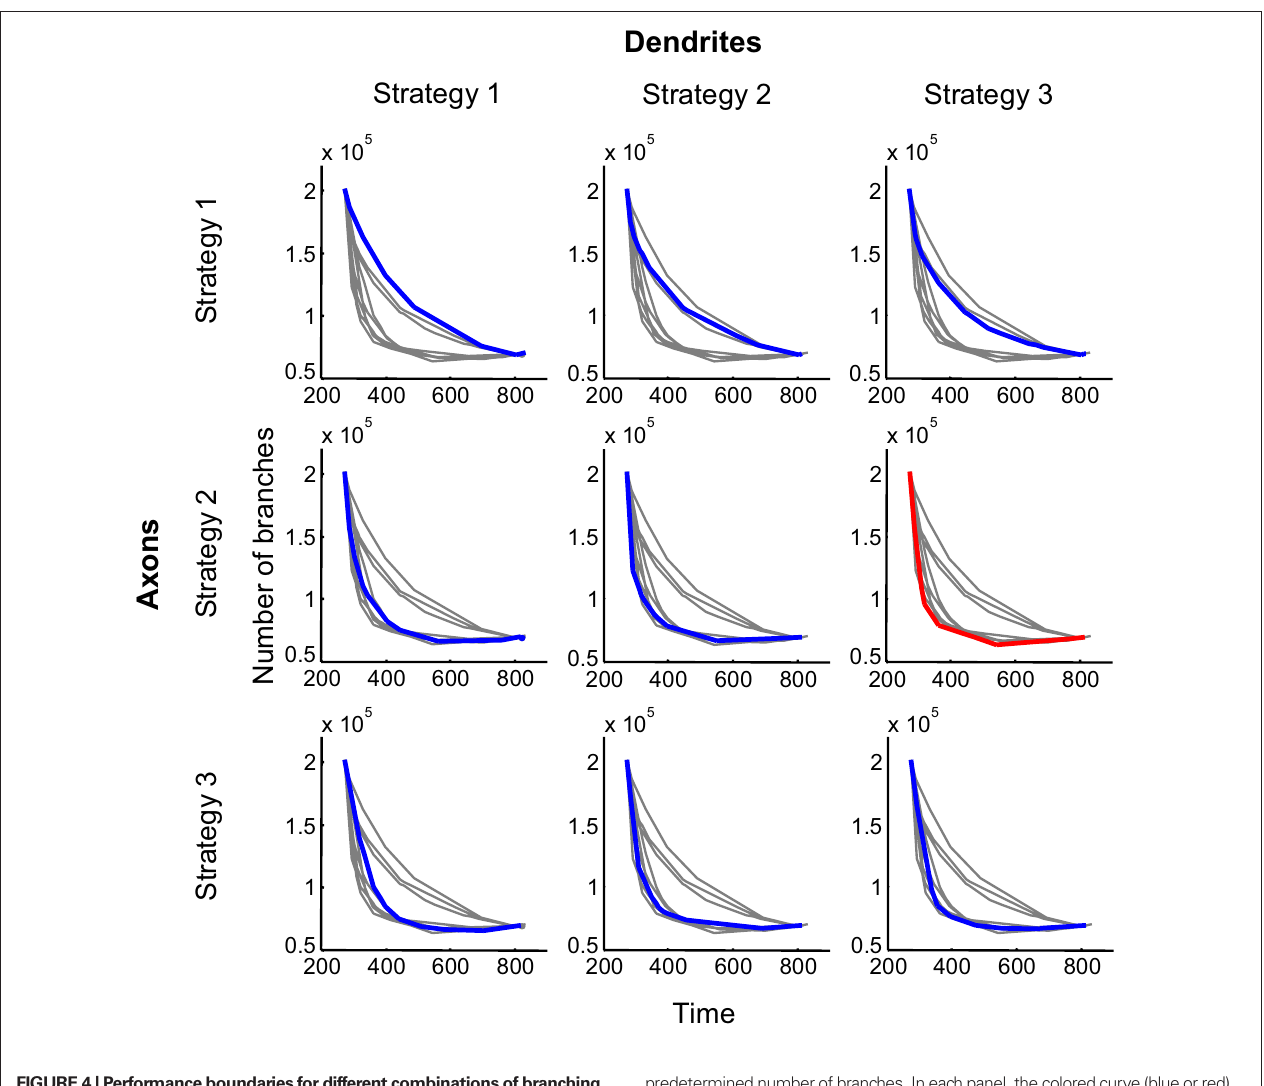
predetermined number of branches. In each panel, the colored curve (blue or red) represents the boundary for a specifi ed combination of branching strategies. The boundaries for other combinations are shown in grey, for comparison. The red curve depicts the optimal performance boundary that corresponds to the combination of Strategies 2 and 3, used by axons and dendrites,